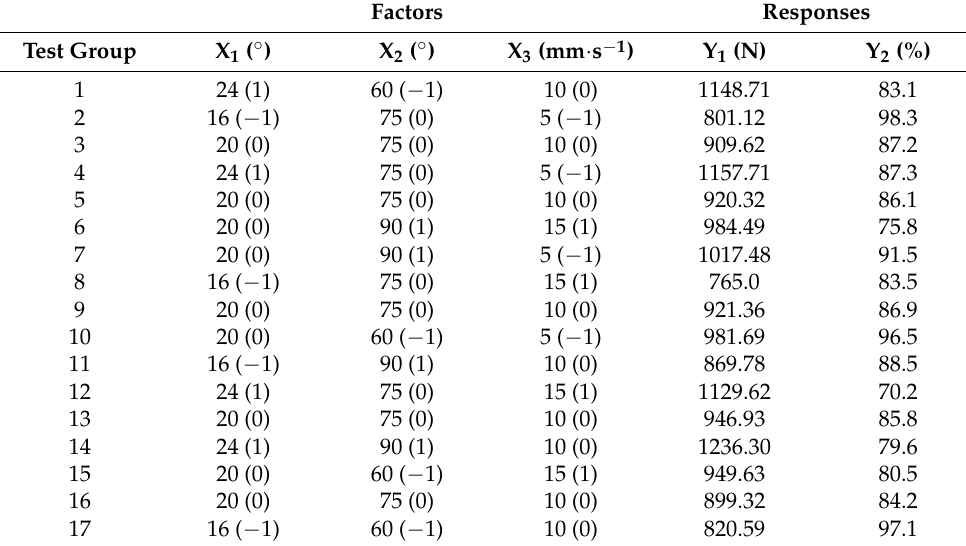
Table 5. BBD matrix and experimental